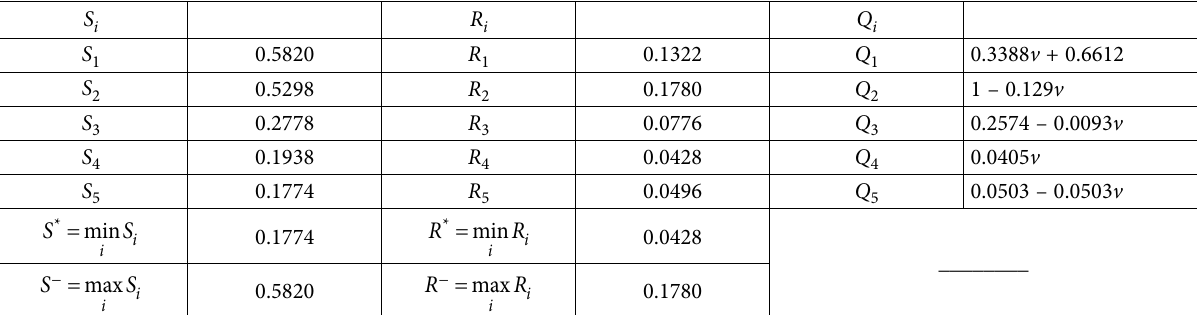
Table 3. The results of calculation on S i , R i and Q